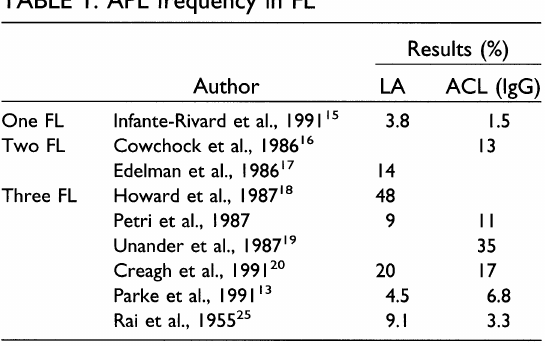
TABLE I. APL frequency in